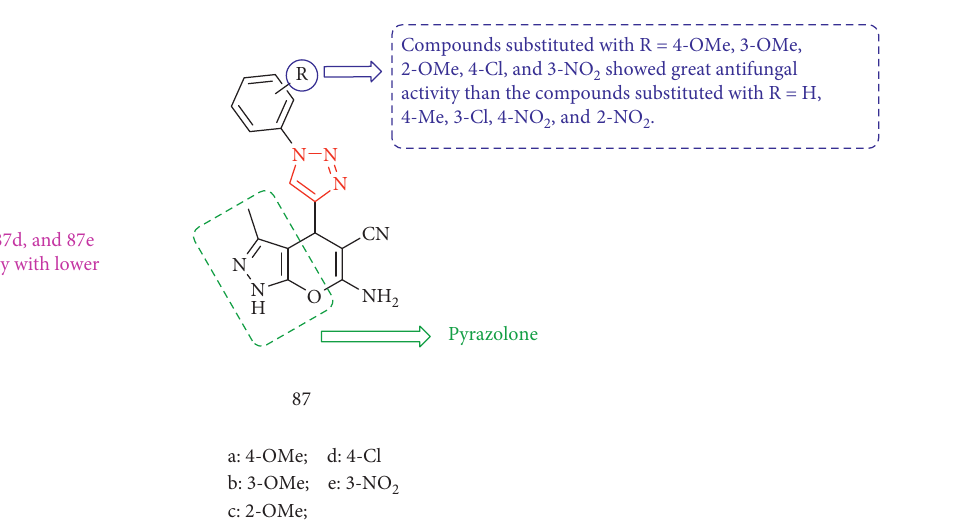
Figure 37: Chemical structure of new 1,2,3-triazolyl pyrano[2,3-c]pyrazole